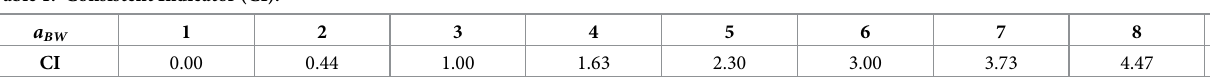
Table 1. Consistent Indicator